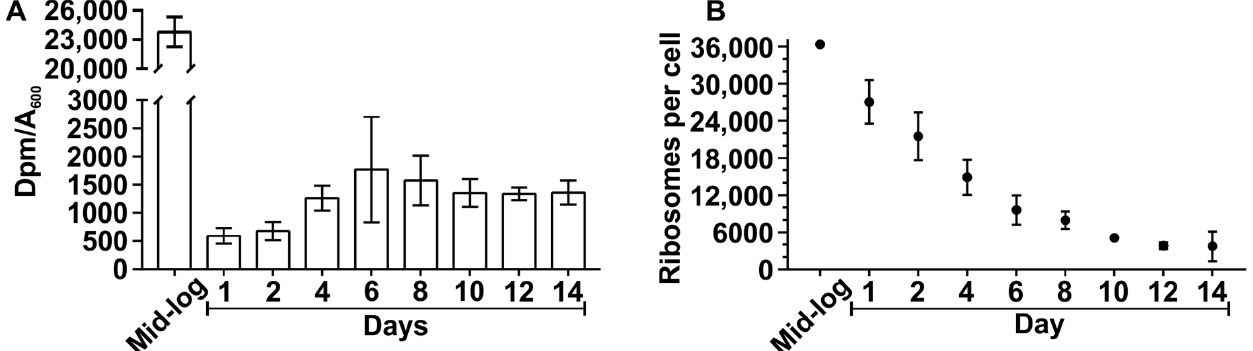
Figure 1. Translation activity during the stationary phase. E. coli culture was grown for 14 days. A radioactive isotope-labeled amino acid mix was added to a portion of the culture at designated time points. Samples were taken every 30 min over 3 h of incubation. Samples were TCA precipitated and the incorporation of the radioactive label over time was measured. Obtained values of disintegrations per minute (DPM) were normalized against A 600 and plotted (see Supplementary Figure S1). ( A ) To evaluate changes in translation activity for 14 days, dpm/A 600 after 60 min of incubation from each time point is shown in the figure. ( B ) The NRC during the stationary phase. Total RNA concentration was determined in the stationary phase and normalized to the mid-log timepoint. The NRC value was calculated, as described in the methods. Values shown in the figure are the mean of three independent biological experiments with standard deviation (n = 3; mean ± SD).